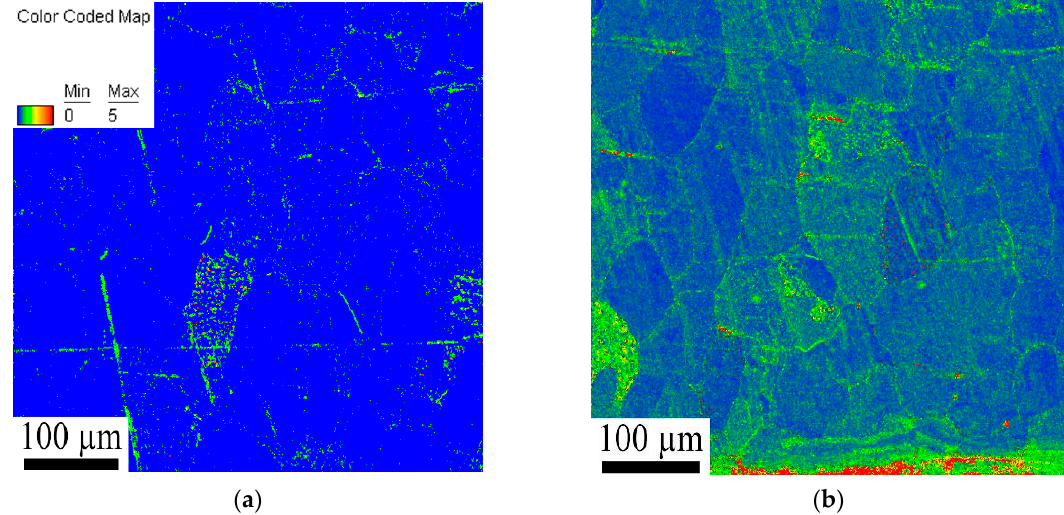
Figure 7. Kernel average misorientation maps of surface layers of ARMCO iron in the initial state ( a ) and after LSP ( b ); the bottom edge of the images corresponds to the surface of the specimen.